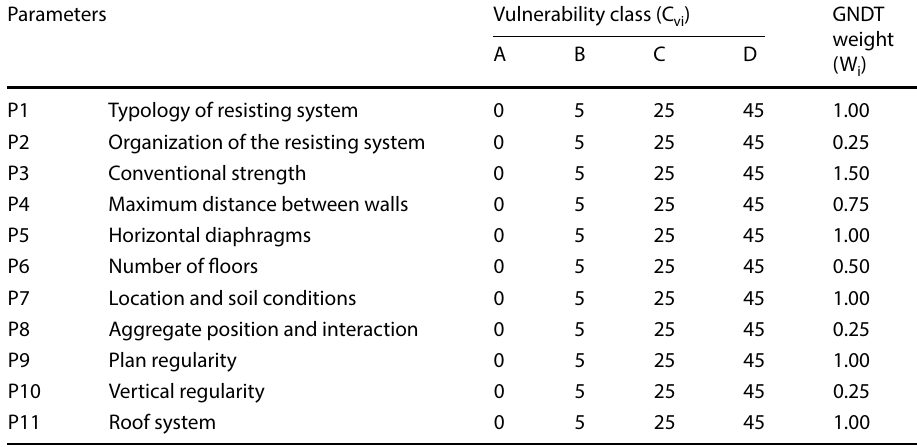
Table 1 GNDT Method Classes and Weights for Masonry Buildings